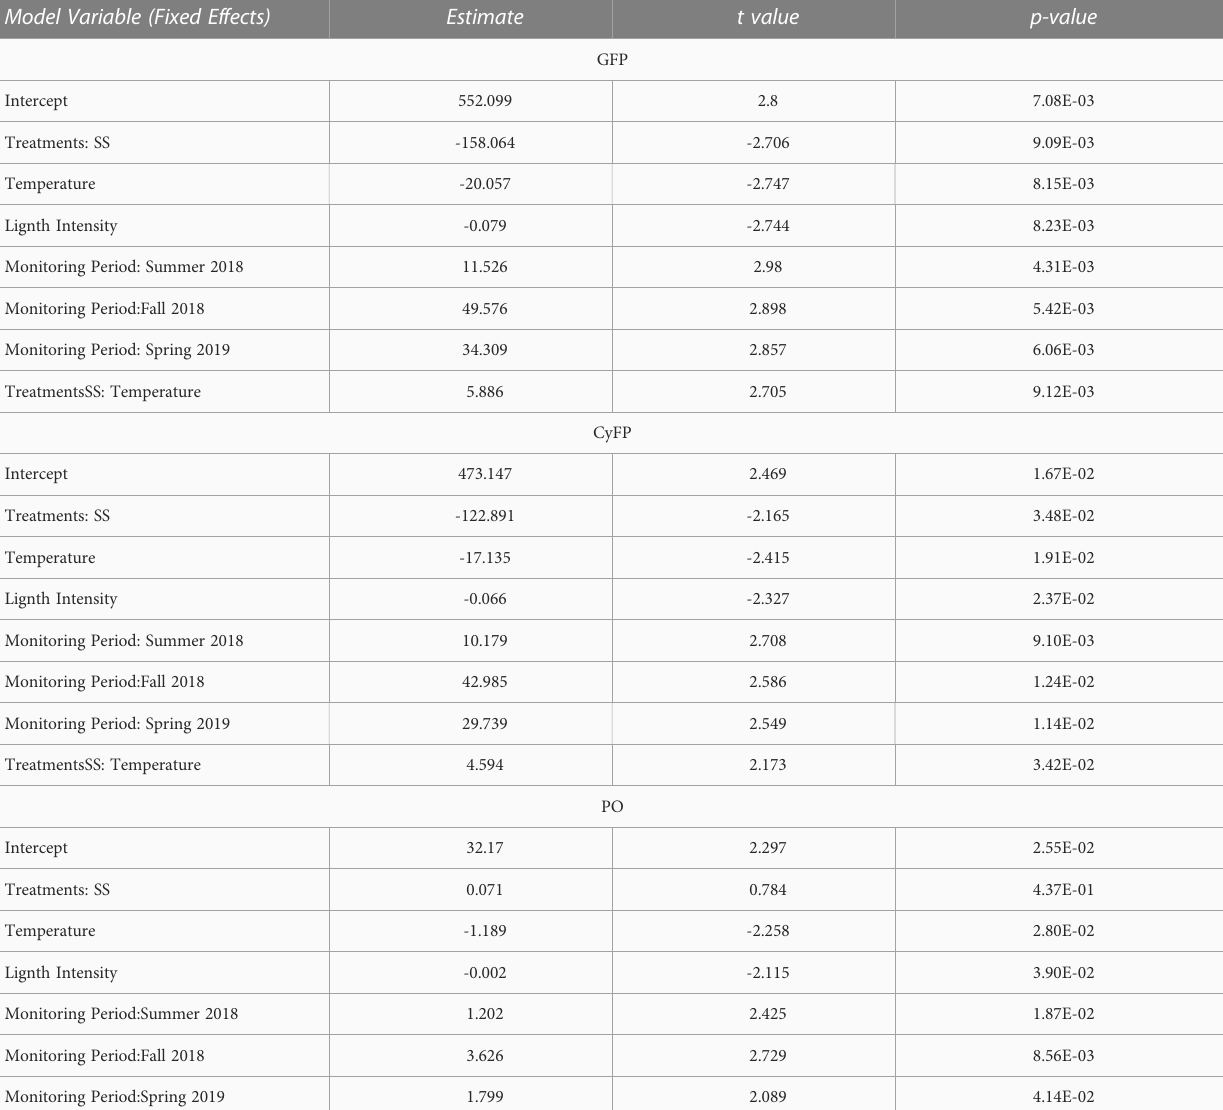
TABLE 2 Fixed effects result from the General Linear Mixed Model (GLMM) analyses for Green Fluorescent Protein (GFP), Cyan Fluorescent Protein (CyFP), and Phenoloxidase (PO) activity from control colonies fi tted by maximum likelihood t-test using Satterthwaite. Model Variable (Fixed